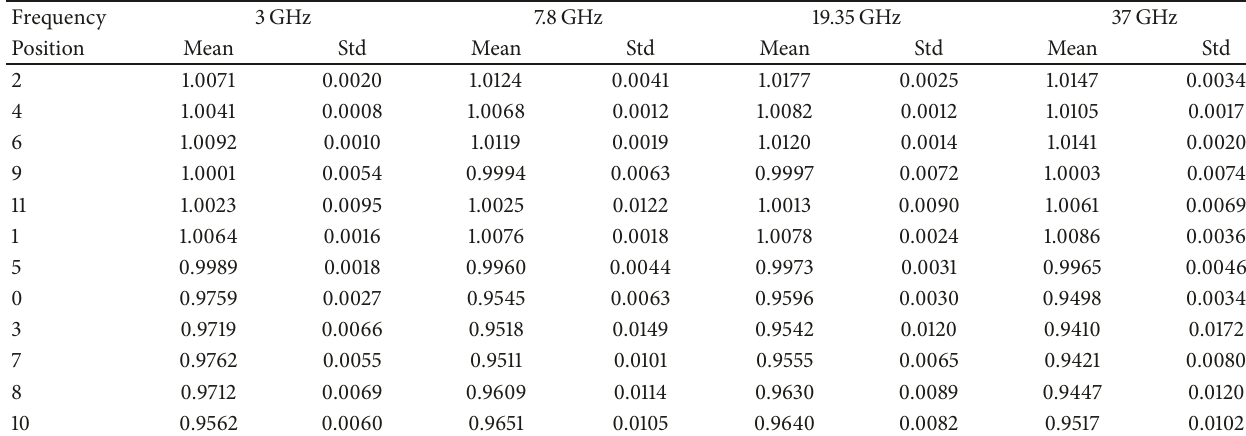
Table 1: n T statistics of samples at B